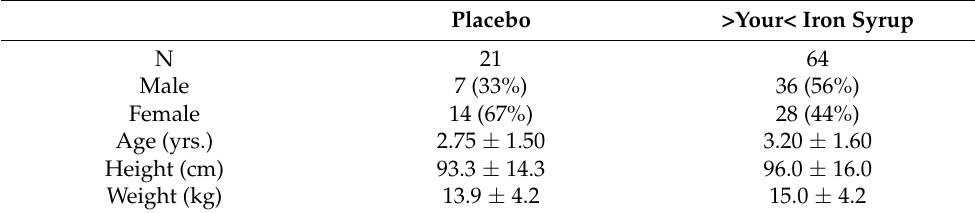
Table 1. Participant demographics and study arm